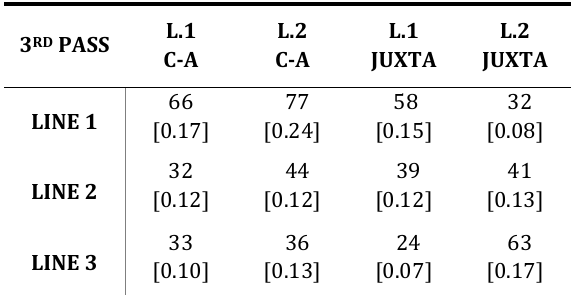
Table 4B. Third-pass dwell times (per word) follow- ing regressive saccades, Fisher Least Square Difference=31 ms [likelihood of re-fixations, Fisher Least Square